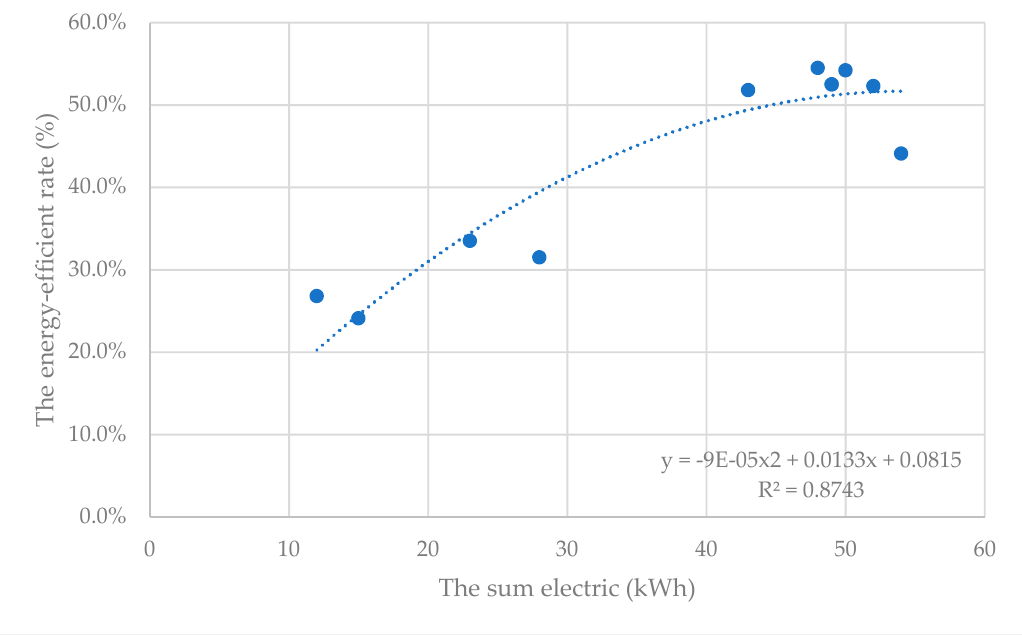
Figure 11. The relation schema of the accumulated electric energy consumption (kWh) and the energy-efficient rate (%).